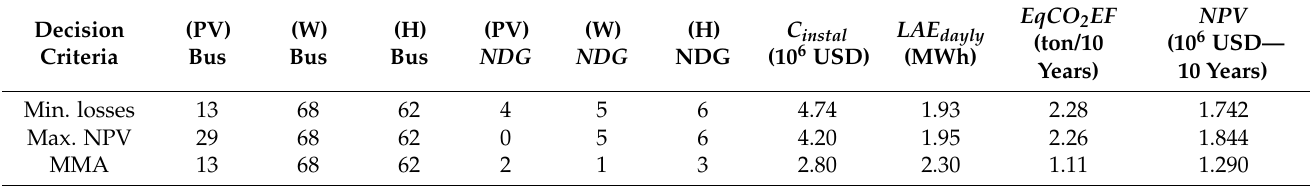
Figure 4. Graphic comparison among objective functions for conflict checking—case-study I.